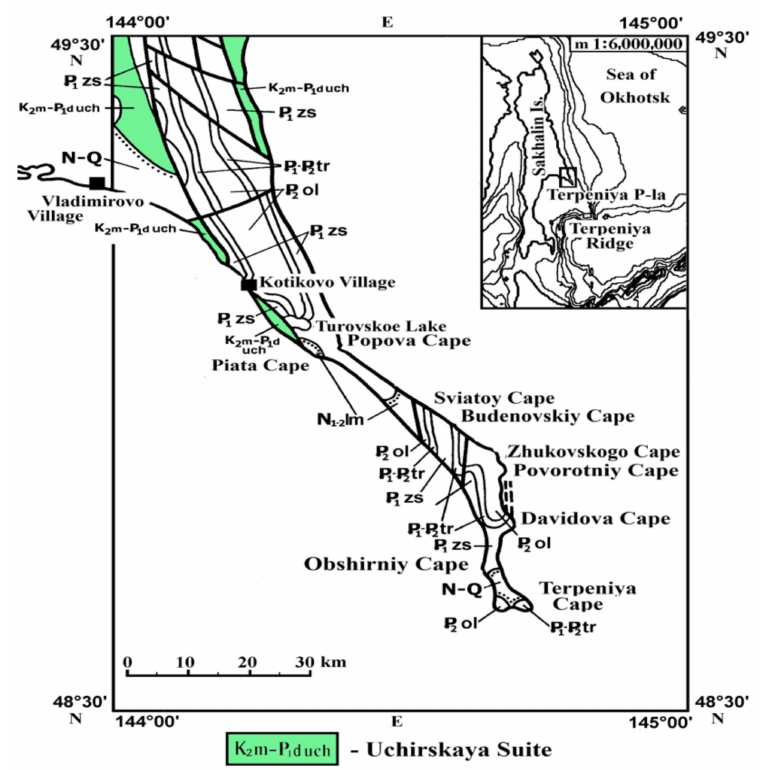
Figure 3. Geological chart of the Terpeniya Peninsula (Sakhalin Island) [14,15].